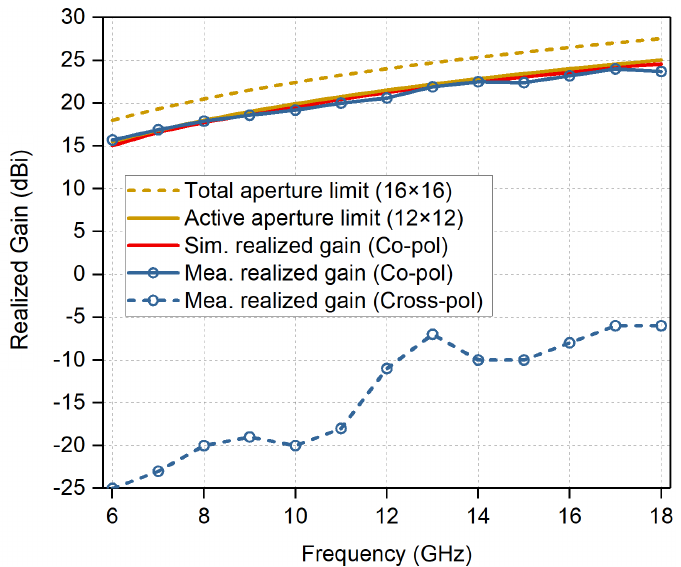
Figure 16. Measured co-polarized and cross-polarized realized gains at broadside of the prototype array, along with the simulated gains and the theoretical aperture